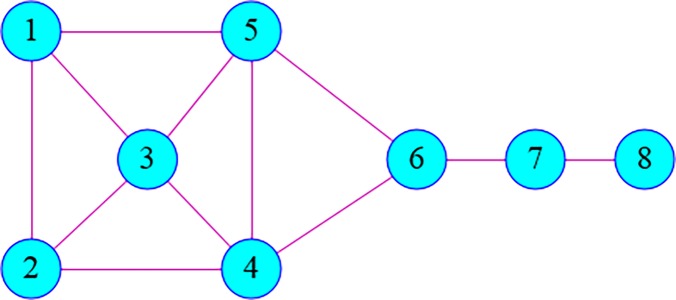
A simple network.